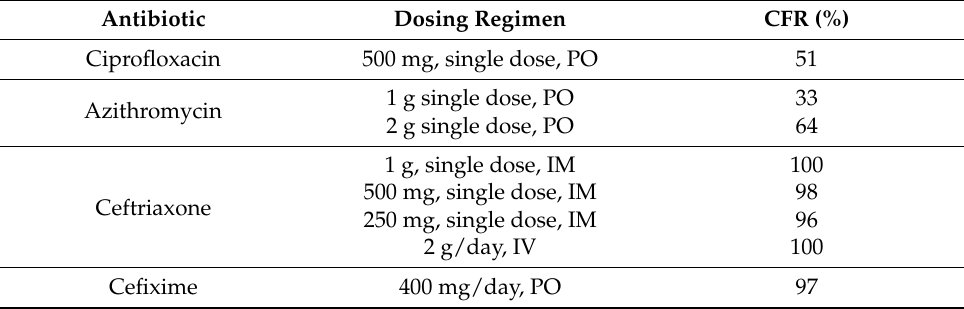
Table 4. Cumulative fraction of response (CFR) calculated for all antibiotics and dosing